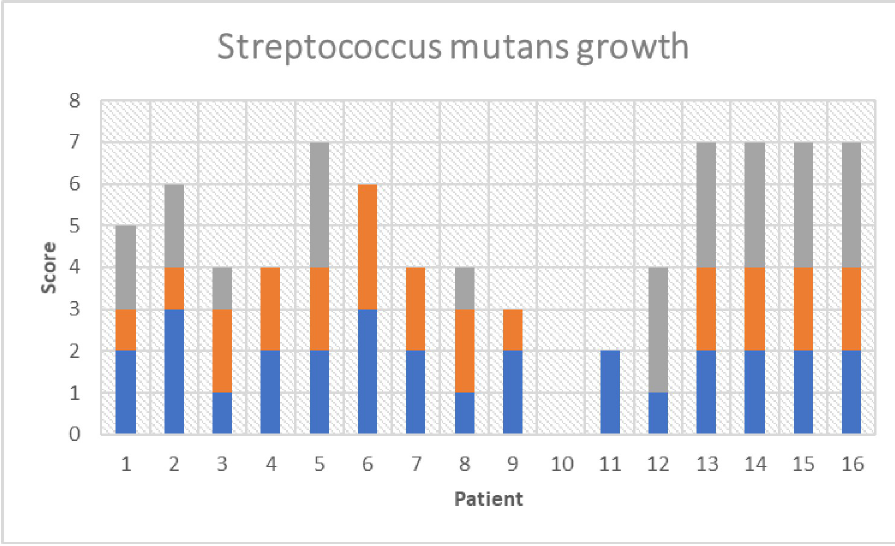
Fig 2. Streptococcus mutans growth score at time 0 (blue bars), just prior to MC consumption, time 1 (orange bars), one week after MC consumption, and time 2 (grey bars), four weeks after starting MC consumption.